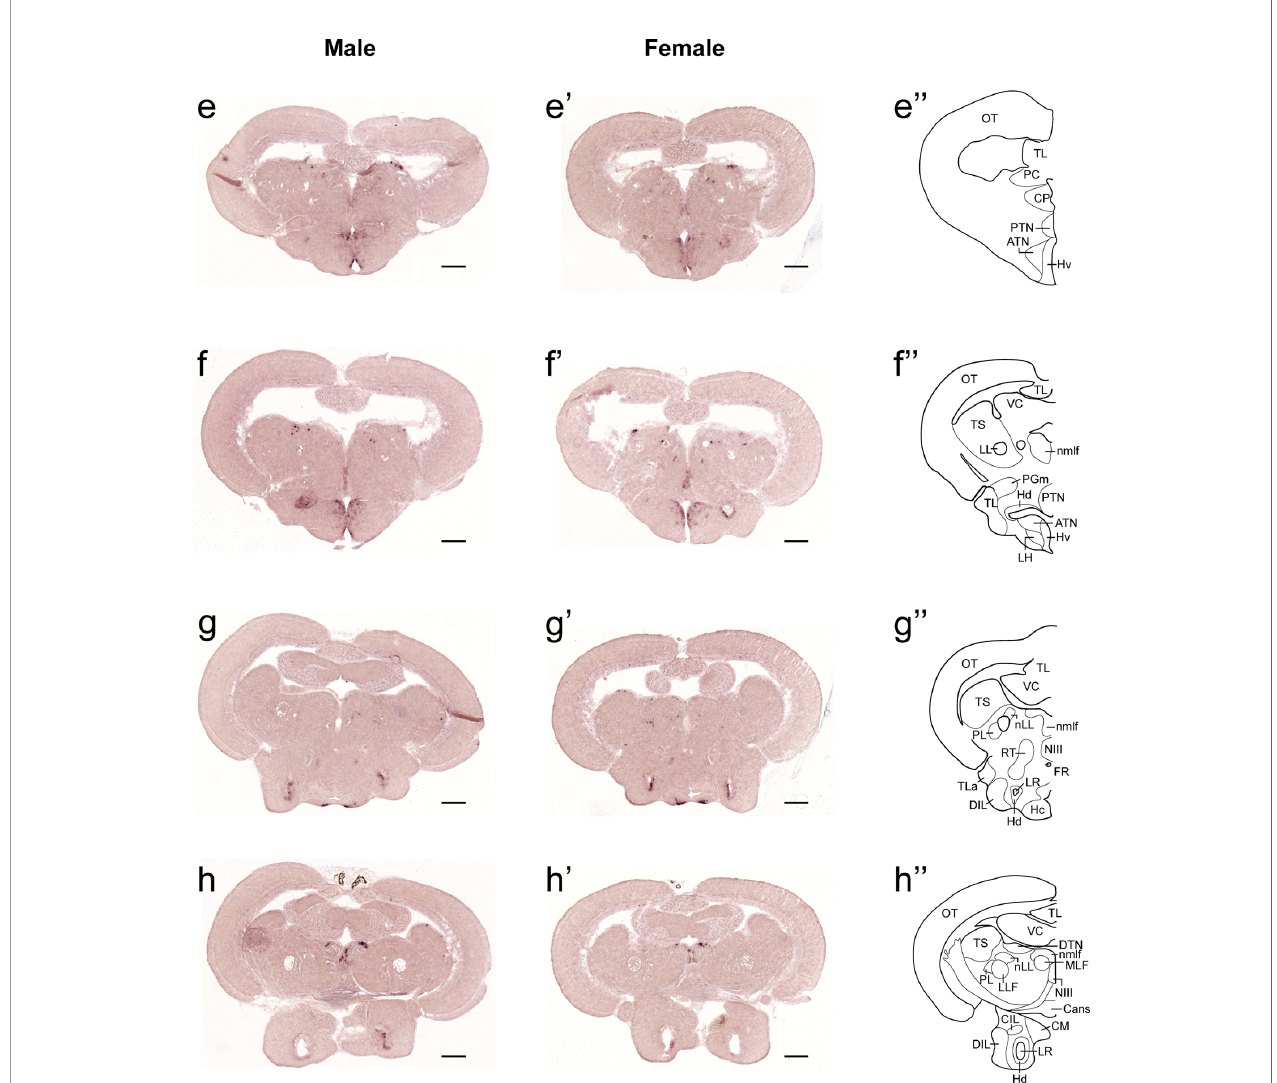
FIGURE 2 | Comparison of expression patterns of tac1 mRNA in the midbrain regions of male (E − H) and female (E ’ − H ’ ) zebra fi sh. In the most-right panels (E ” − H ” ) , a schematic drawing of half of the brain section (left side) processed for tac1 staining indicating major brain structures at this level. There was no sex difference in expression of tac1 in the diencephalic and mesencephalic regions including the torus semicircularis, dorsal tegmental nucleus, posterior tuberal nucleus, caudal and dorsal zones of the periventricular hypothalamus, nucleus of medial longitudinal fascicle, and oculomotor nucleus. Scale bars: 200 µm. See Glossary for